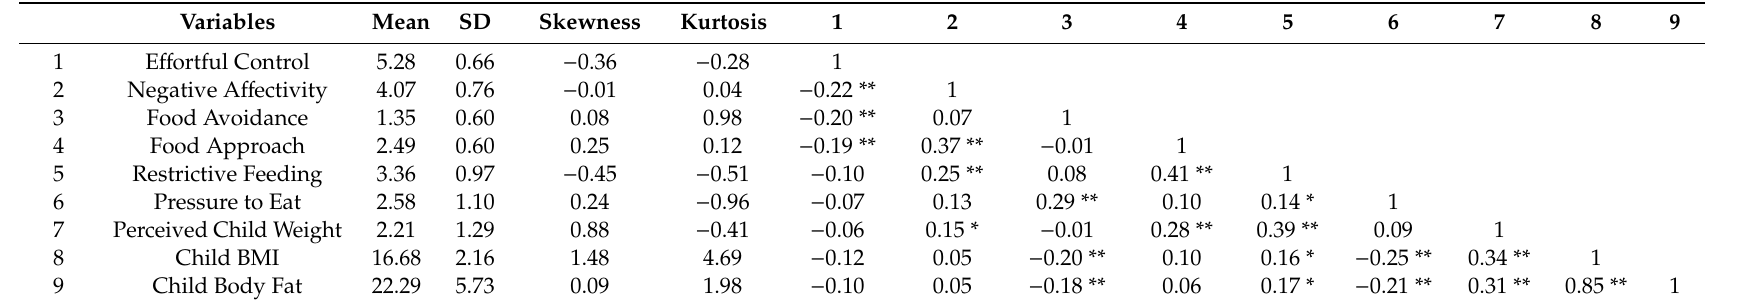
Table 1. Correlations and descriptive statistics for all variables.